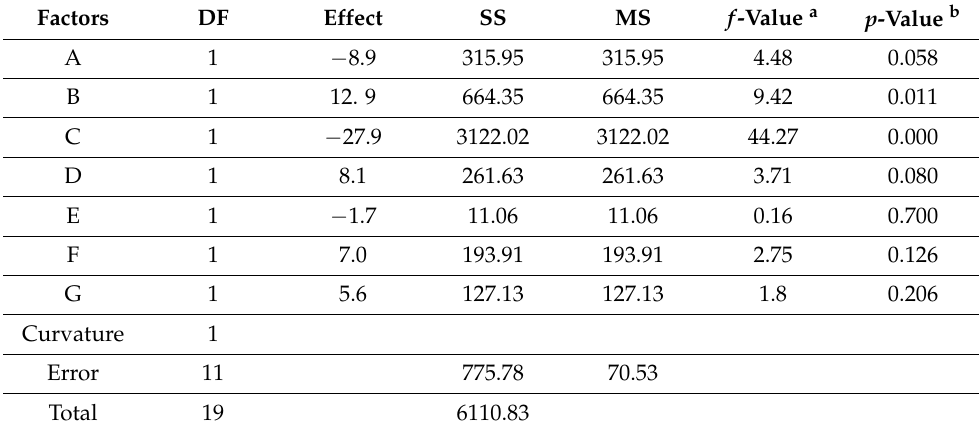
Table A2. ANOVA for Single Factor Effects on 1,2-PD Selectivity Analysis.